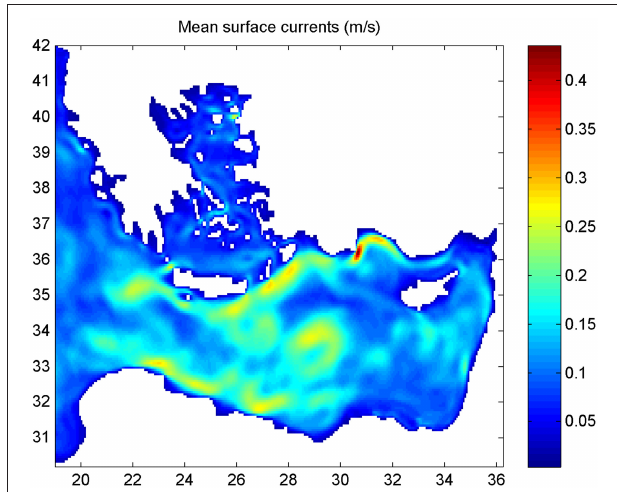
FIGURE 8 | Mean surface currents for the Eastern Mediterranean during